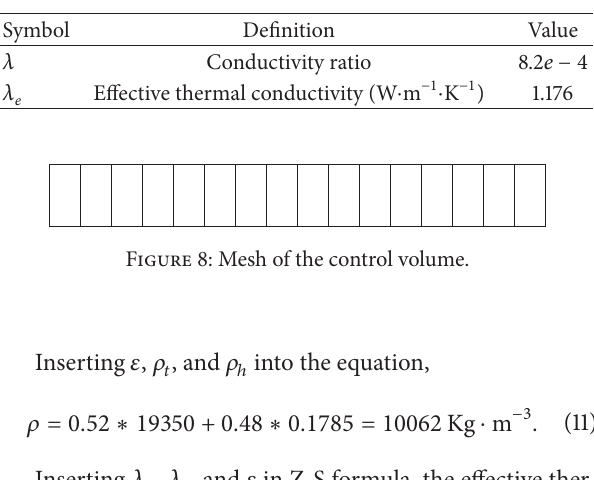
Table 2: Quantities calculated by Z-S formula.